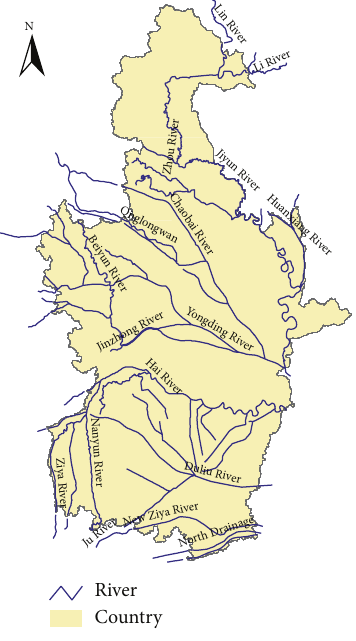
Figure 5: Rivers in Tianjin.